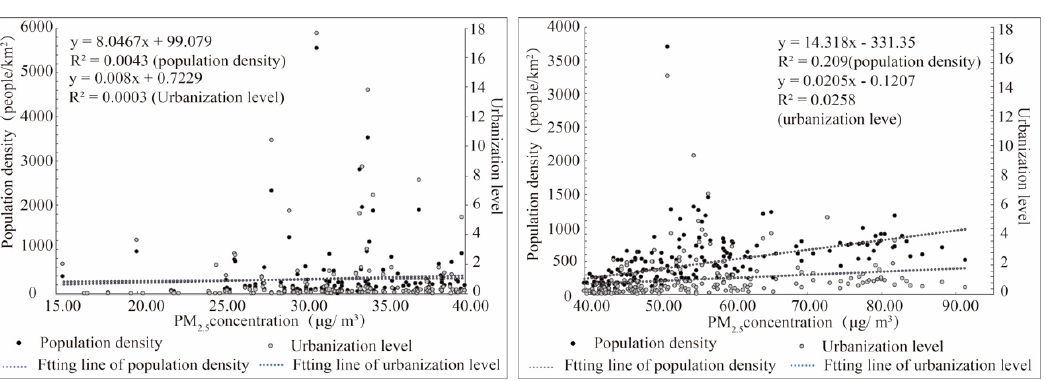
Figure 3. The fitting relationship between PM 2.5 concentration and population density as well as urbanization level. The ( left ) figure is fitting relationship in low-concentration and the ( right ) one is fitting relationship in high-concentration.